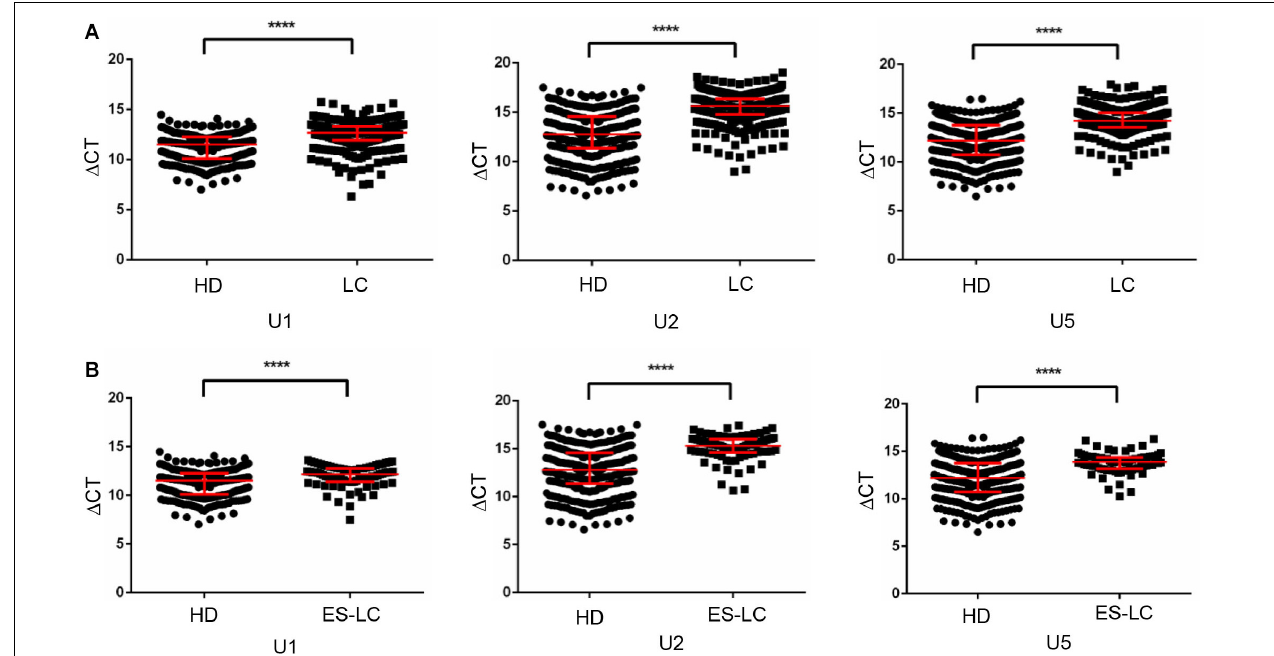
FIGURE 1 | TEP U1, U2 and U5 were downregulated in lung cancer. (A) TEP U1, U2, U5 were down-regulated in lung cancer patients ( n = 382) compared with healthy controls ( n = 361); (B) TEP U1, U2, U5 were down-regulated in early stage lung cancer patients ( n = 80) compared with healthy controls ( n = 361). HD, healthy donors; LC, lung cancer patients; ES-LC, early stage lung cancer patients. **** p <